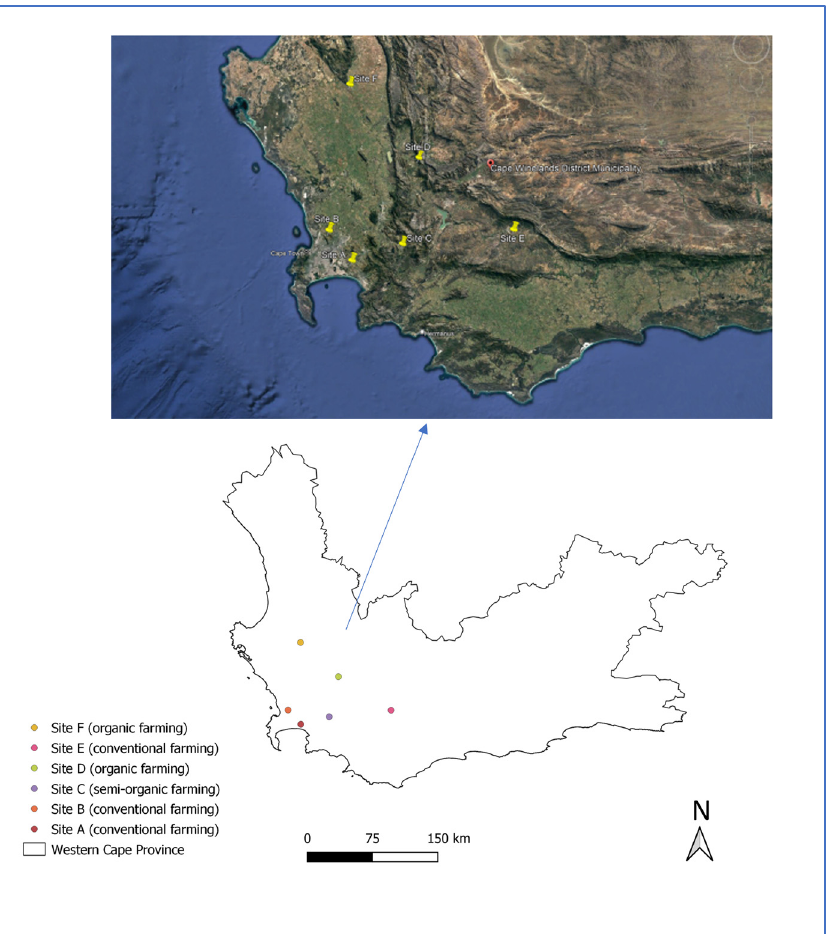
Figure 1. A map of the sampled vineyard sites in the Cape Winelands region; the map was created using QGIS and Google Earth